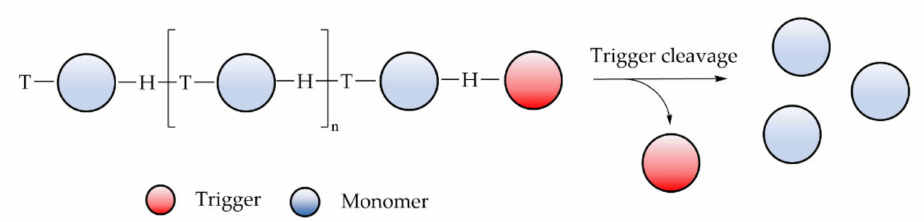
Figure 9. Scheme of disassembling of a self-immolative